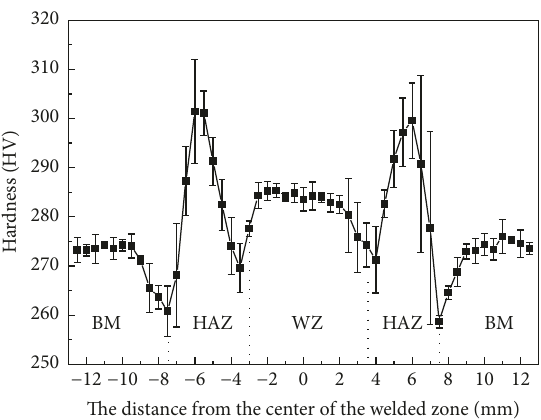
Figure 3: The distribution of the hardness in the welded